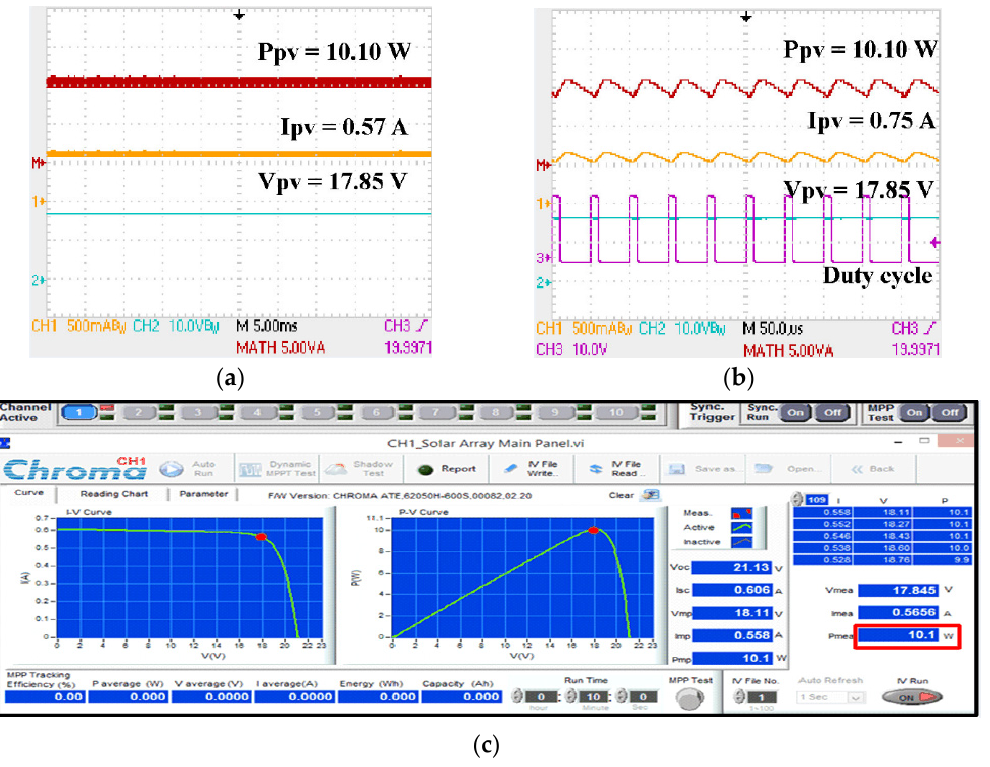
Figure 21. Modified LFO at 200 W/m 2 , ( a ), ( b ), ( c ) reflect same result.